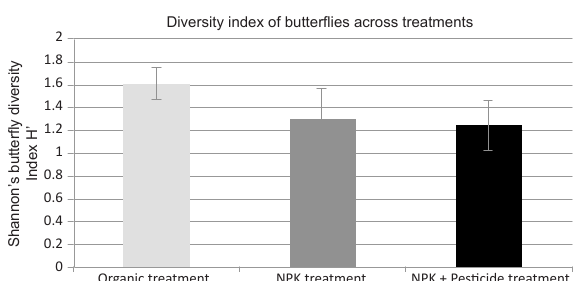
Figure 7. Bar plot for butterflies shows mean Shannon’s diversity index values H’ for all treatments with their 95% confidence intervals